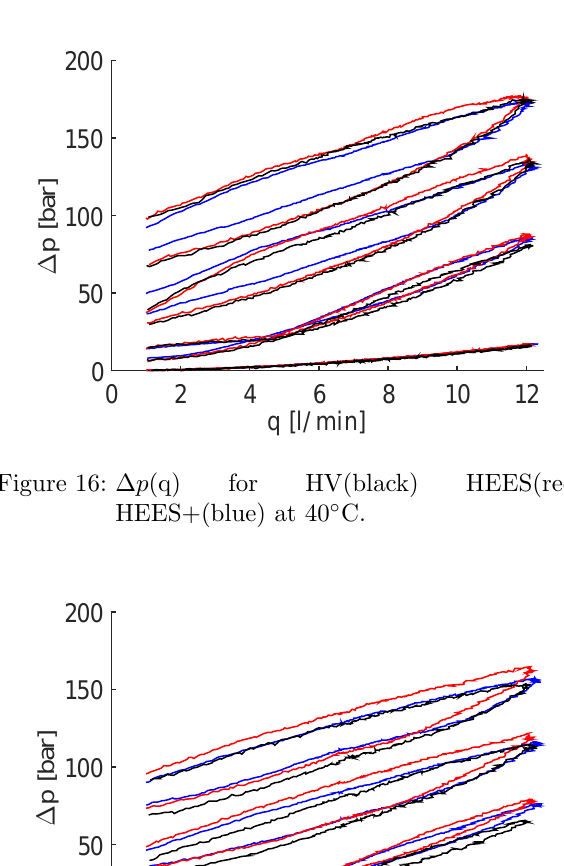
Figure 15: ∆ p (q) for HV(black) HEES(red) HEES+(blue) at 20 ◦ C.